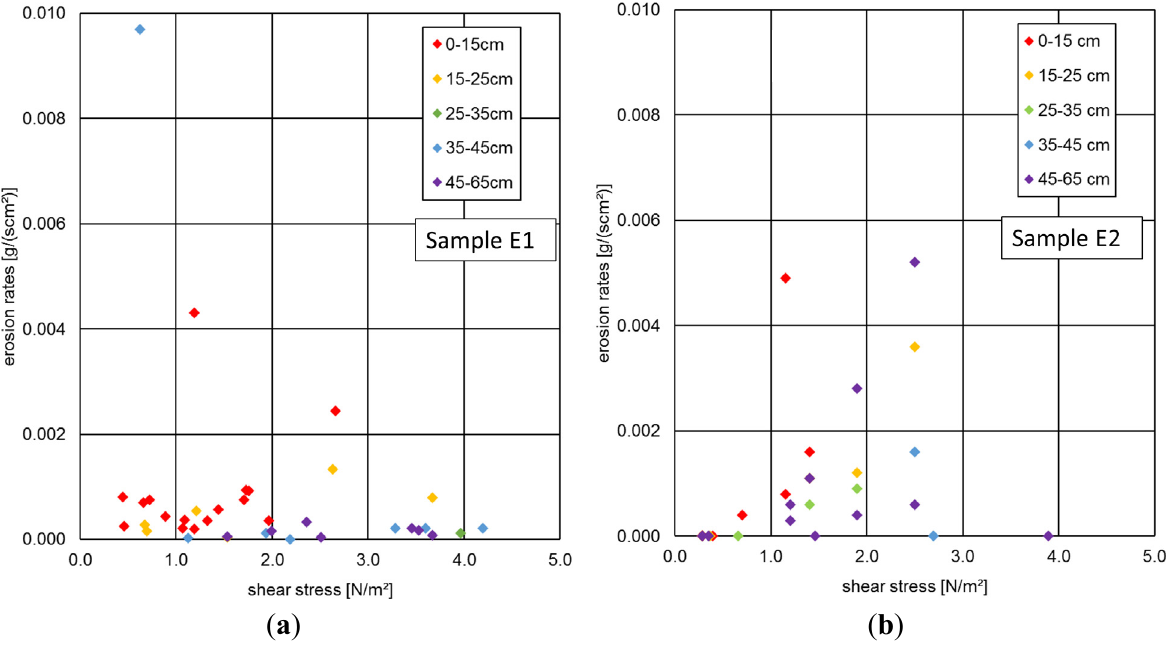
Figure 4. Measured erosion rates in the River Elbe at a stepwise increase of hydraulic forces expressed by shear stresses (( a ): sample E1, ( b ): sample E2). The colors indicate the